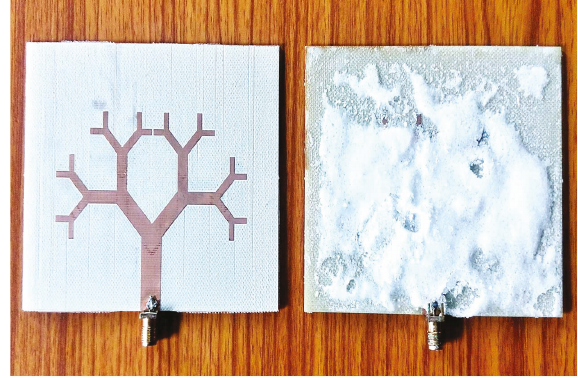
Figure 2: Proposed antenna